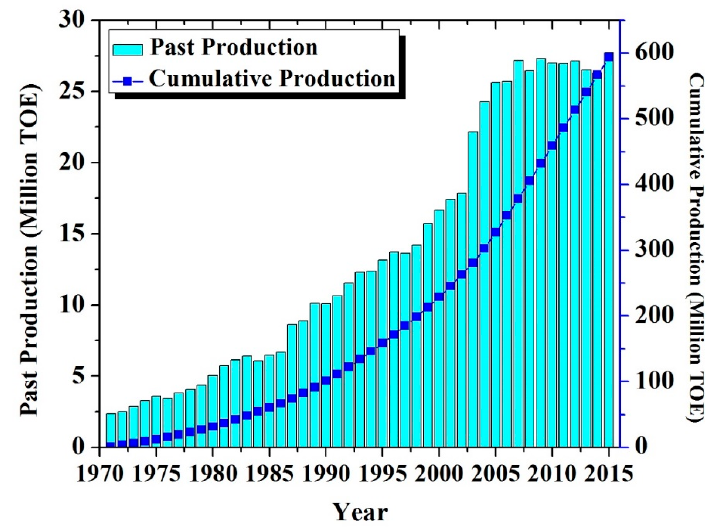
Figure 14. Natural gas past and cumulative production (million toe).